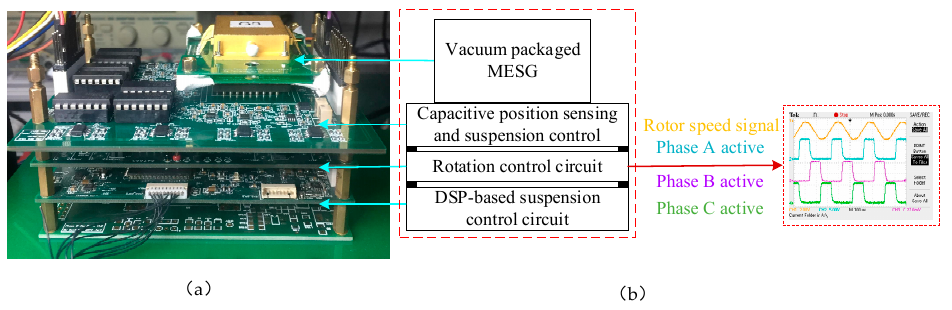
Figure 9. ( a ) Experimental set-up of the MESG and ( b ) the rotor drive